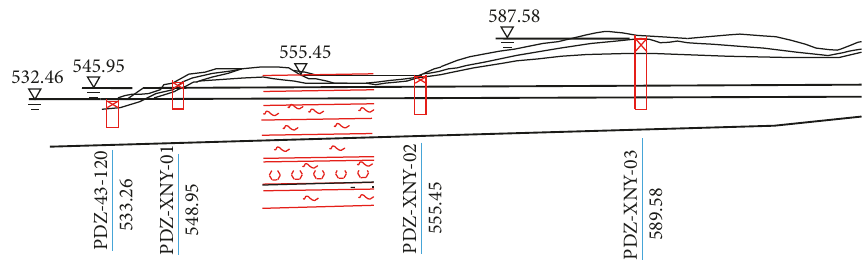
Figure 2: Longitudinal section drawing of the simulation section.